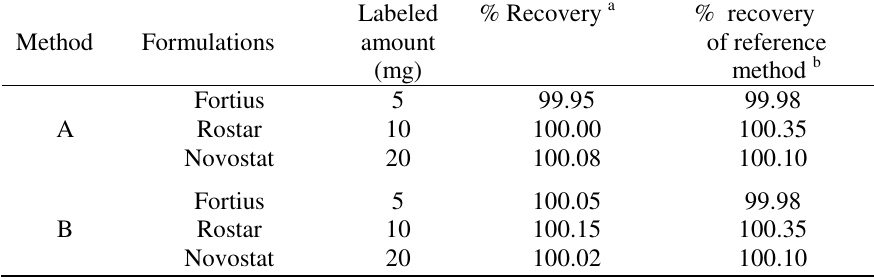
Table2 . Results of analysis of tablet formulations containing